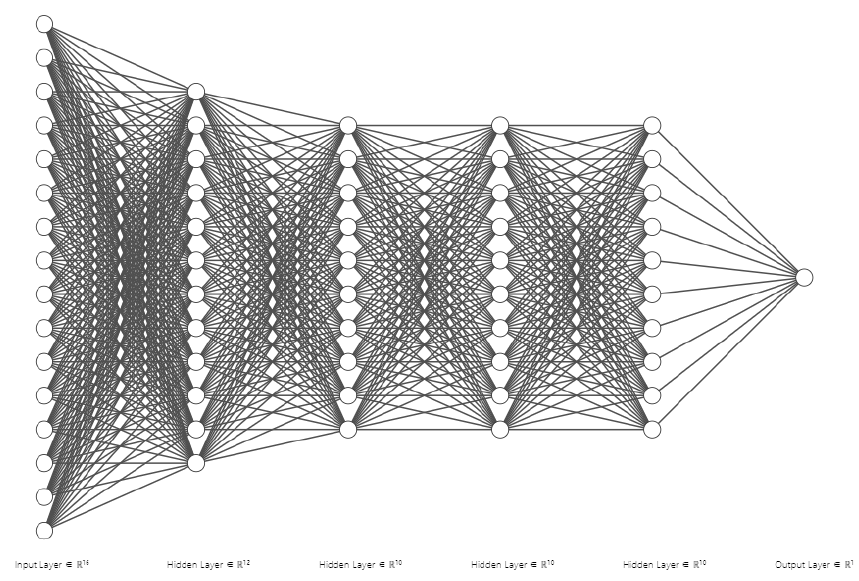
Figure 5. DNN structure diagram.